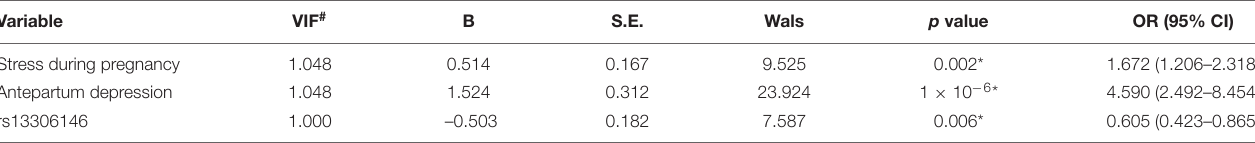
TABLE 3 | The association of rs13306146 and PDS with logistic analysis. Variable